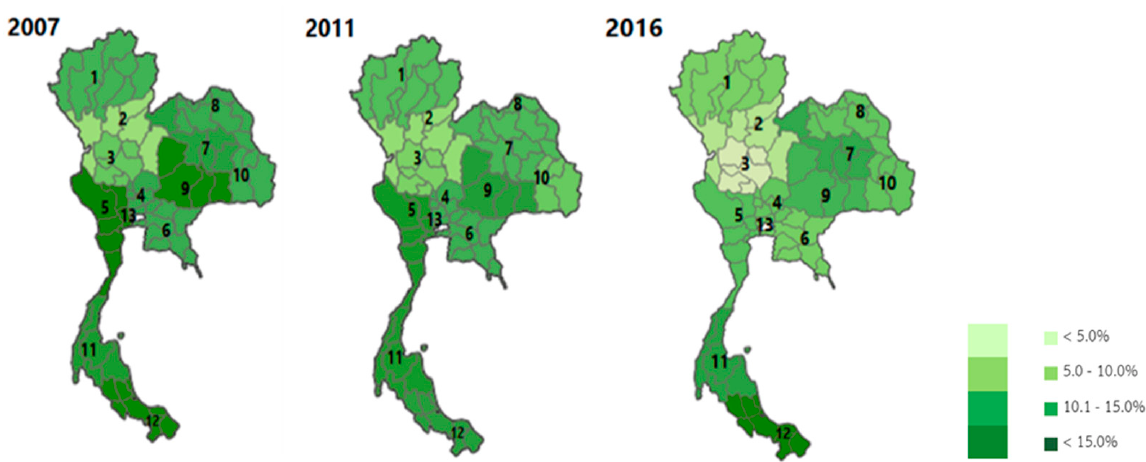
Figure 2. Regional variations in hospital admission rates in different periods of policy changes.